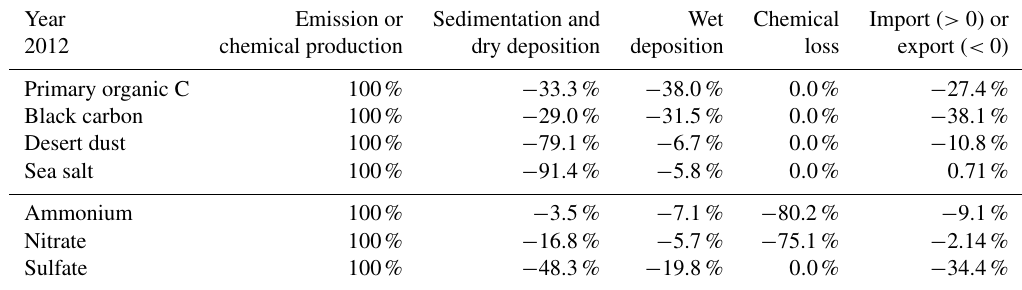
Table 13. Same as Table 12 but for 2013. Year Emission or Sedimentation and Wet Chemical Import ( > 0) or 2013 chemical production dry deposition Primary organic C Black carbon Desert dust Sea salt Nitrate